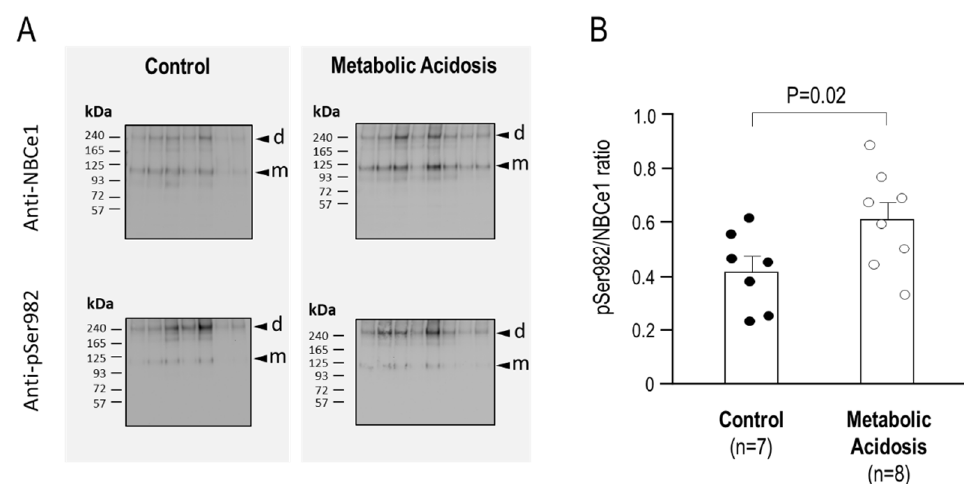
Figure 9. The influence of 24 h metabolic acidosis on the pSer982 status of renal NBCe1 protein. ( A ) Western blots showing anti-NBCe1 and anti-pSer982 immunoreactivity (dimer (d), and monomer (m)) in mice that had ad libitum access to drinking water containing 0.5% sucrose (control) or 0.5% sucrose plus 0.28 M NH 4 Cl (metabolic acidosis); ( B ) Quantification of the ratio of pSer982/NBCe1 in control versus metabolic acidotic mice. Equal protein loading and transfer among blots was confirmed using MemCode reversible (total) protein stain (see Supplemental Figure S3).